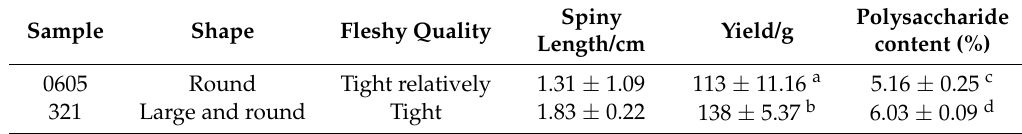
Figure 1. The fruiting bodies of H. erinaceus 321 ( a ) and H. erinaceus 0605 ( b ). Table 1. Comparative analysis of agronomic characteristics of H. erinaceus .